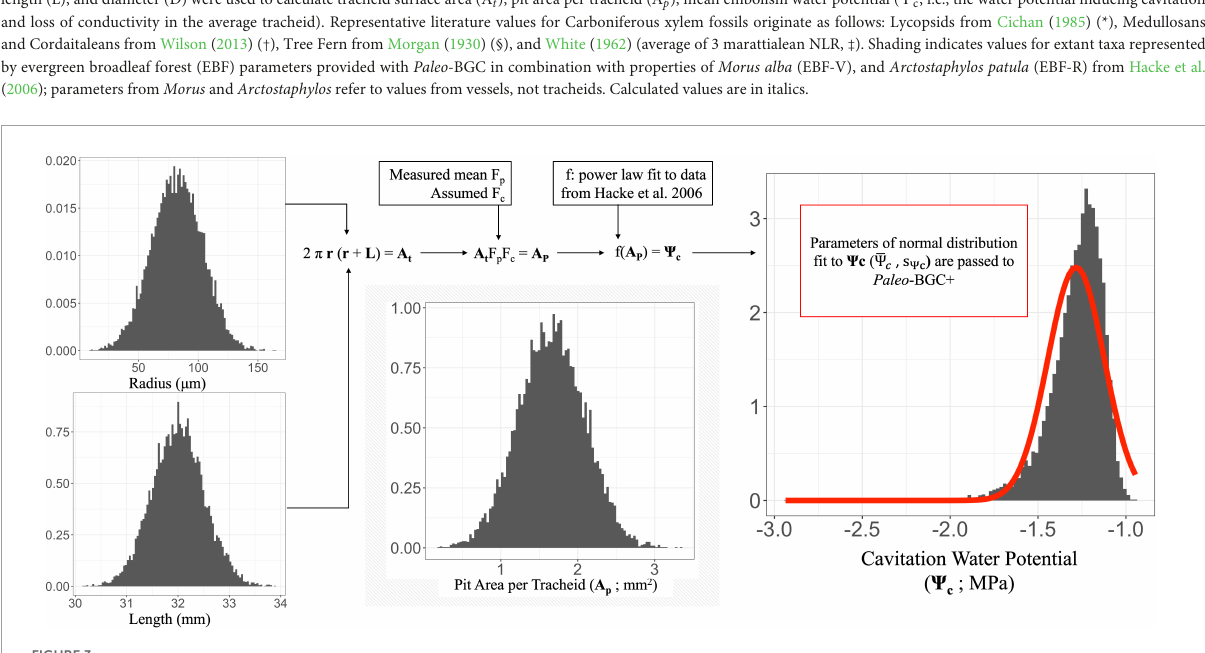
FIGURE3 Graphical description of calculations leading to simulated vulnerability curves from fossil plant xylem morphological and anatomical measurements. Density plots of all distributions based on simulated data (tracheid radius – r, tracheid length – L, pit area per tracheid – Ap, and cavitation water potential – (cid:57) c); all vertical axes are simulated frequencies. Numerical vectors containing distributions are represented in formulae in bold font. Calculations are performed element-wise on these vectors, effectively assuming a covariance of 1 between r and L. While r and L do positively co-vary (e.g., Sperry et al., 2006), the relationship is variable among taxa. However, in the absence of morphological and anatomical measurements sufficient to infer the true distribution of these traits an assumed covariance is necessary, and this choice to yields deterministic and interpretable model behavior. Red line represents the normal distribution fitted to (cid:57) c, the parameters of which are used to calculate a cumulative distribution function (CDF) of the same normal distribution in Paleo -BGC+. These CDFs correspond to the